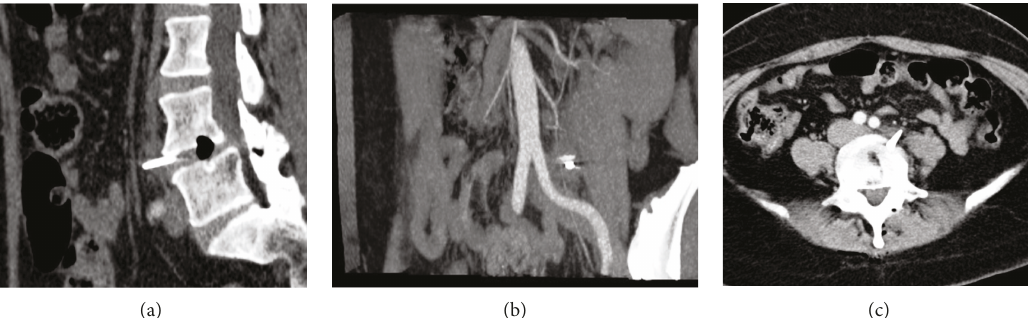
Figure 1: (a) Sagittal, (b) coronal, and (c) axial computer tomography angiography views, revealing the broken no. 11 th scalpel blade in front of the L4/L5 intervertebral space.